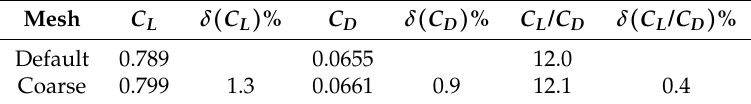
Table 4. Sensitivity study on mesh resolution for Re = 10 4 and AoA = 4 ◦ . Default correspond to a mesh with ≈ 6 × 10 6 cells, coarse corresponds to a mesh with ≈ 3 × 10 6 cells. δ is the relative difference with the default mesh resolution case.